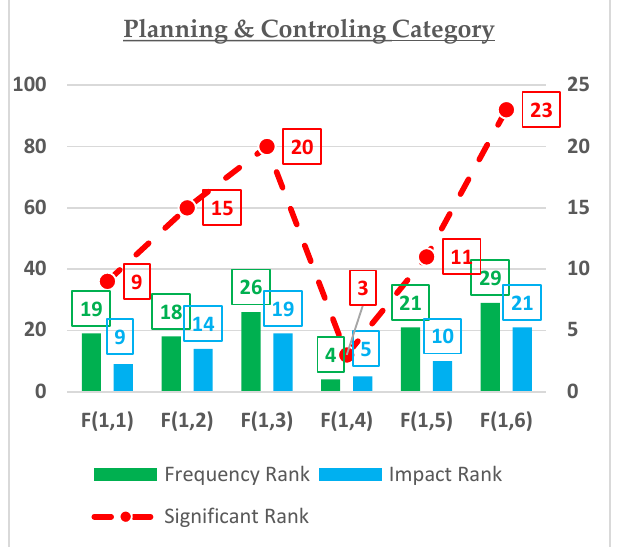
Figure 7. Significant risks in the planning and controlling category.